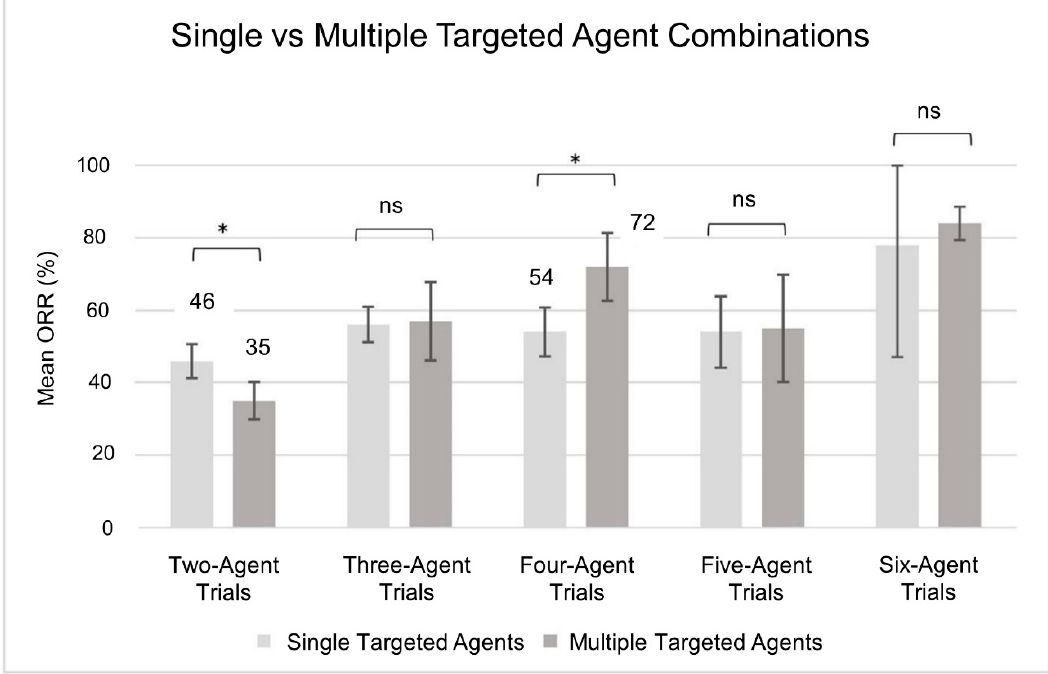
Figure 3. Increasing the number of targeted agents does not increase ORR. Single and multiple-targeted agent combinations contain one and more than one targeted agents, respectively, with or without non-targeted agents. Single-targeted agent trials, n = 290 and multiple-targeted agent trials, n = 167. The bars and error bars represent the mean ORRs and 95% confidence interval, respectively. The statistical significance was estimated by two-tailed Student’s t -test, * p < 0.05.